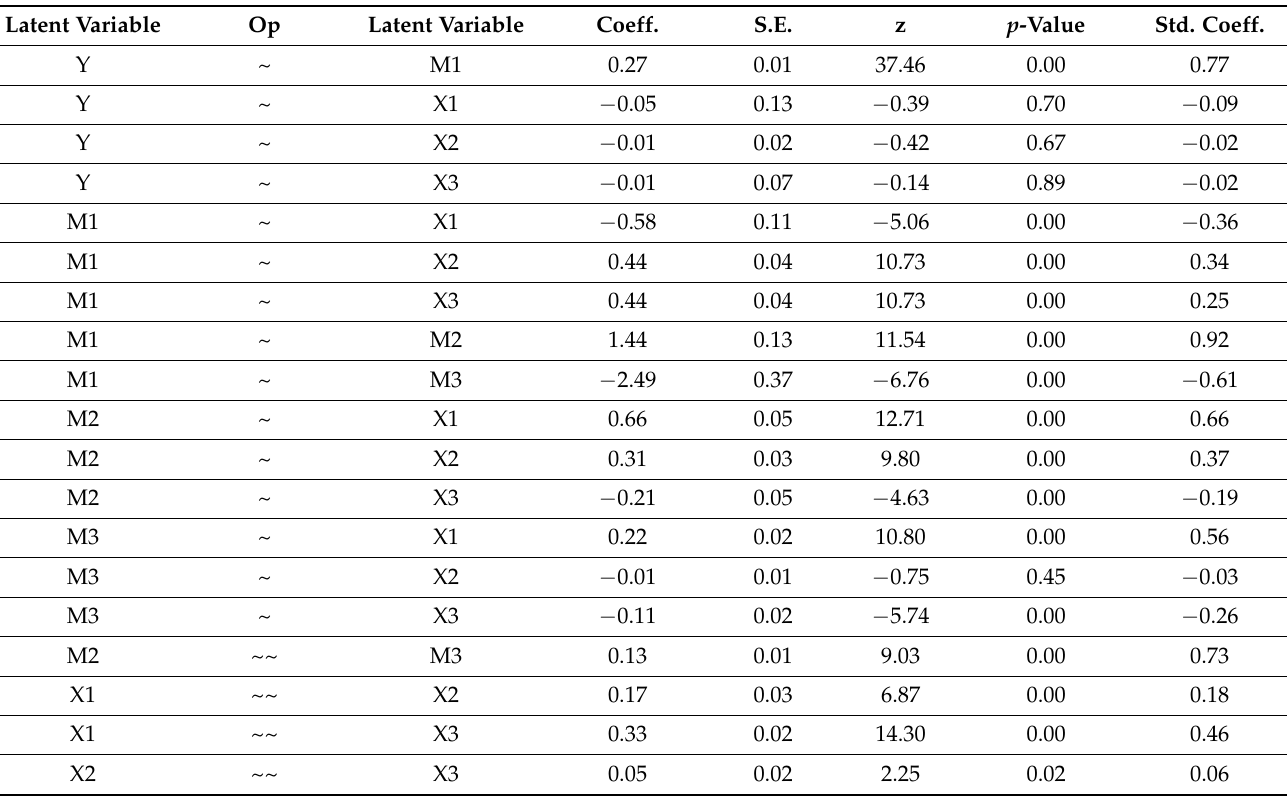
Table 2. Regressions and covariances.